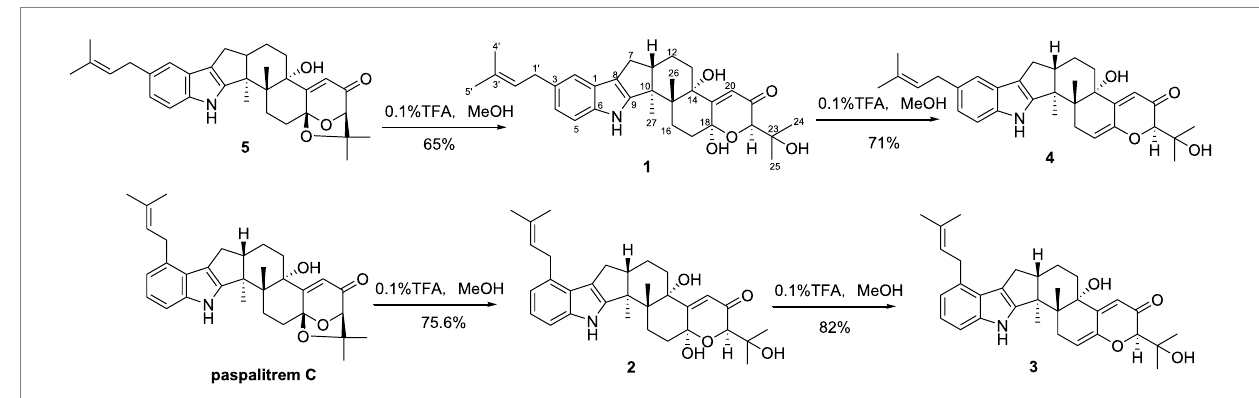
SCHEME 1 The transformation of 5 to 1 and 4 and paspalitrem C to 2 and 3 in acidic reaction